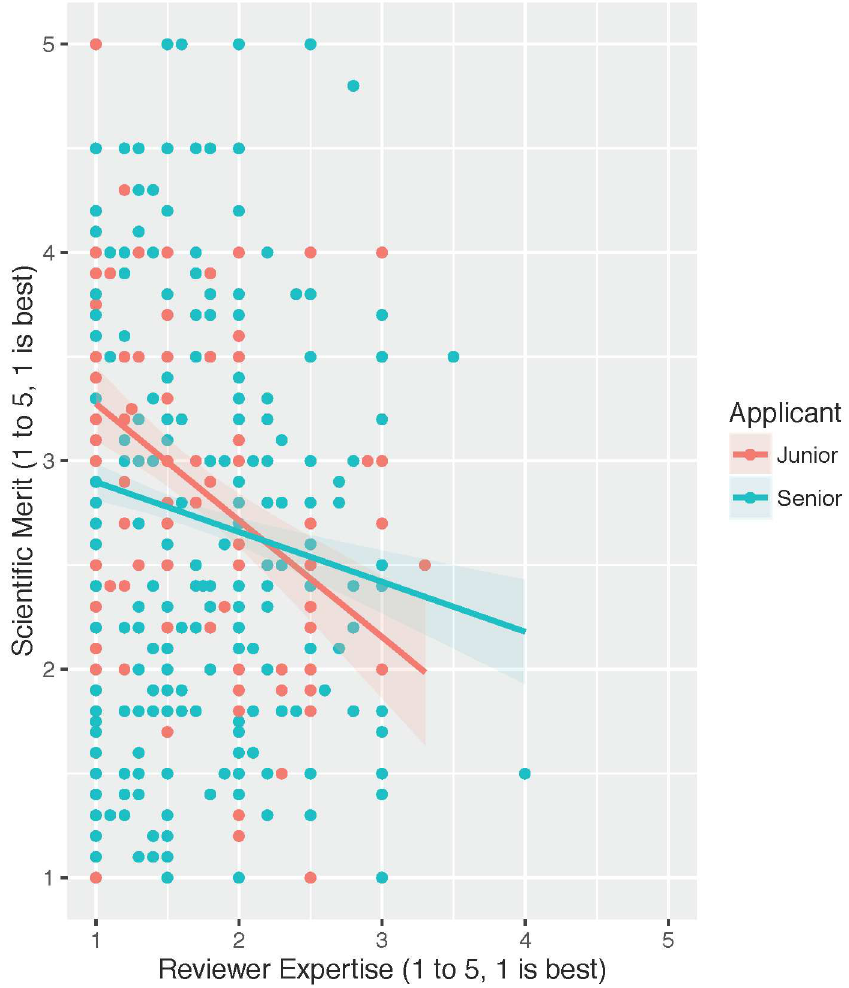
Fig 4. Applicant Seniority Scatterplots of SM versus RE. Scatterplot and linear fit of raw SM versus RE scoring data of all evaluationsof junior applicants (red) and non-junior applicants(blue). The shaded area represents 95% confidence